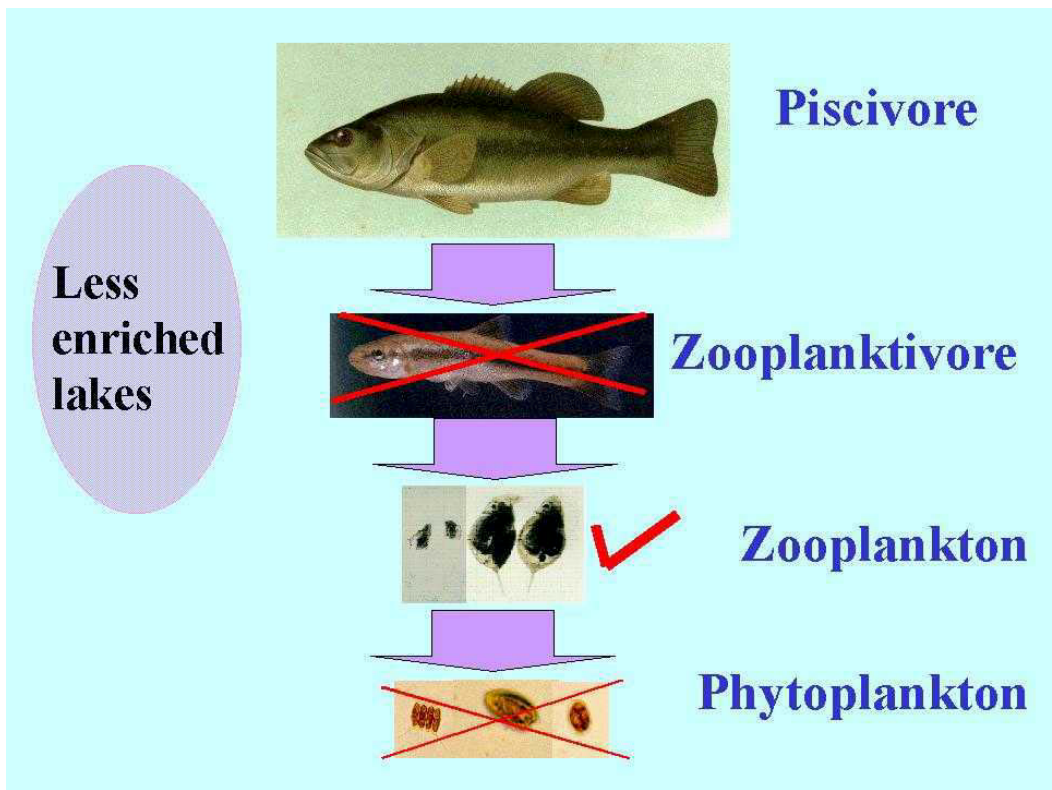
FIGURE 13. Conceptual diagram of traditional biomanipulation for the control of algal